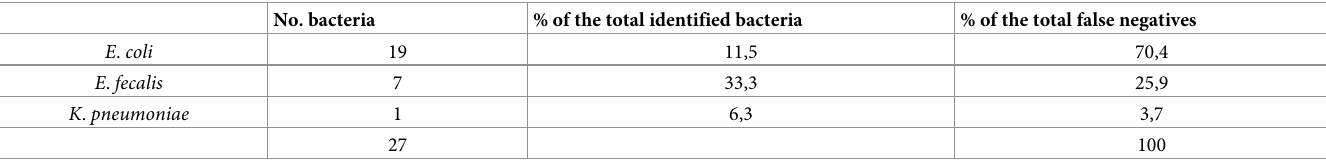
Table 4. Prevalence of bacteria in false negatives samples with cut-off value bacteria � 100.000/mL and WBCs � 10/ μ